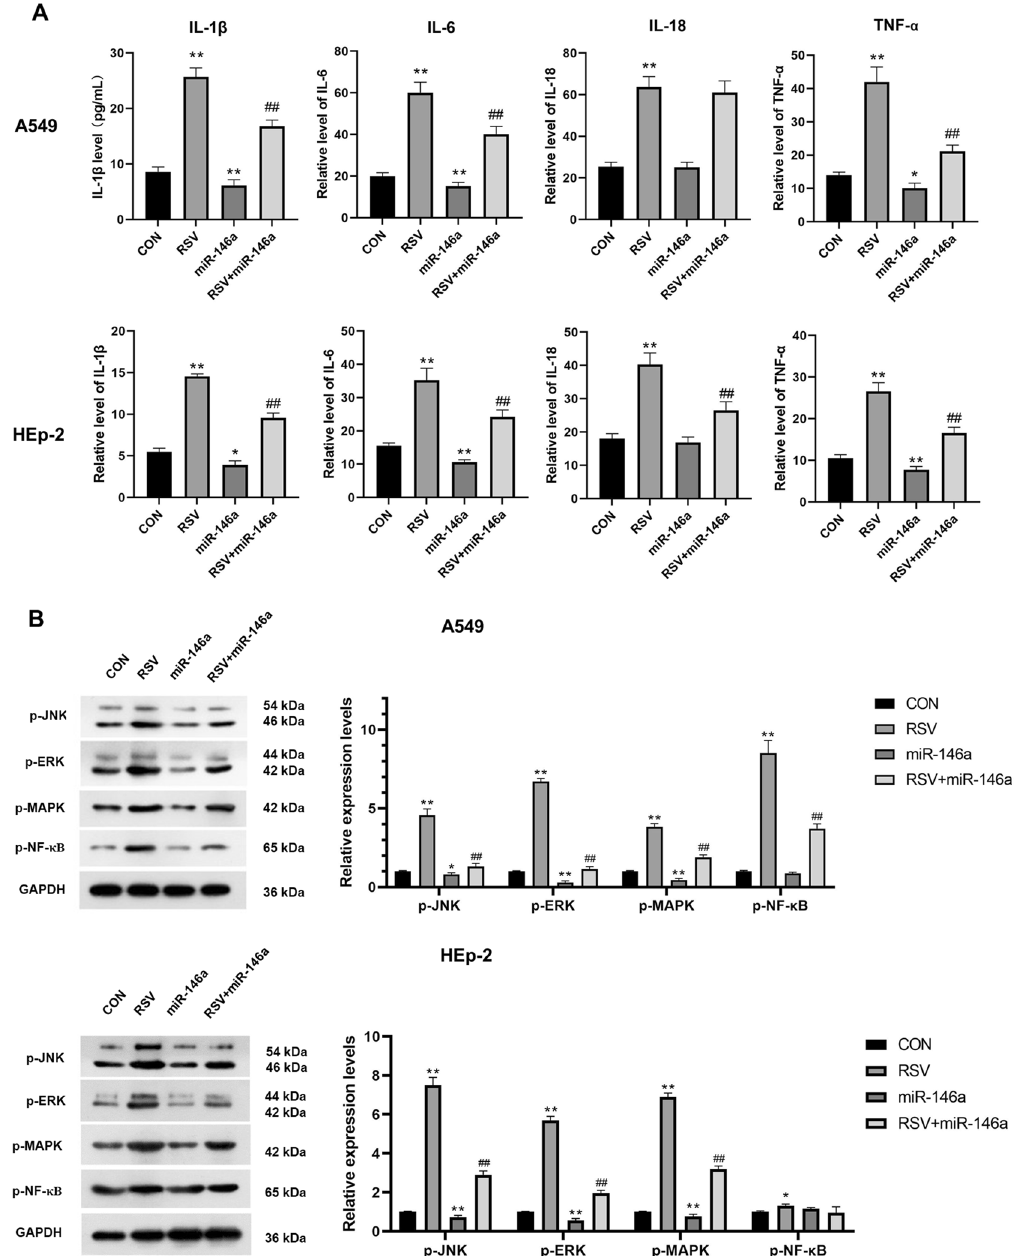
Figure 3. Overexpression of miR-146a inhibits RSV-induced inflammatory cytokines release and JNK/ ERK/MAPK/NF-κB pathway activation in both A549 and HEp-2 cells. ( A ) Levels of inflammatory cytokines, including IL-1β, IL-6, IL-18 and TNF-α, in A549 and HEp-2 cells in each group; ( B ) Protein expression levels of JNK, MAPK, ERK and NF-κB in A549 and HEp-2 cells in each group; * P < 0.05, ** P < 0.01, compared with the CON group; ## P < 0.01, compared with the RSV